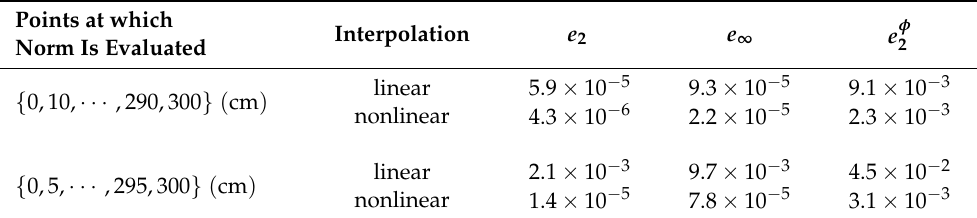
Figure 8. k eff against control-rod height. The dotted line corresponds to the reduced-order model results (GPOD) using the linear interpolation, and the solid line corresponds to the nonlinear interpo- lation. Two unseen temperature profiles are used—the first is uniform and the second sinusoidal (see Equation (48)). For comparison, high-fidelity model results are shown. Table 2. Error in k eff and scalar flux predicted by the reduced-order model (GPOD) for the known ROM temperature profile θ = 291°C and control-rod heights as stated. Values for both linear and nonlinear interpolation are given (see Equations (28) and (42)).